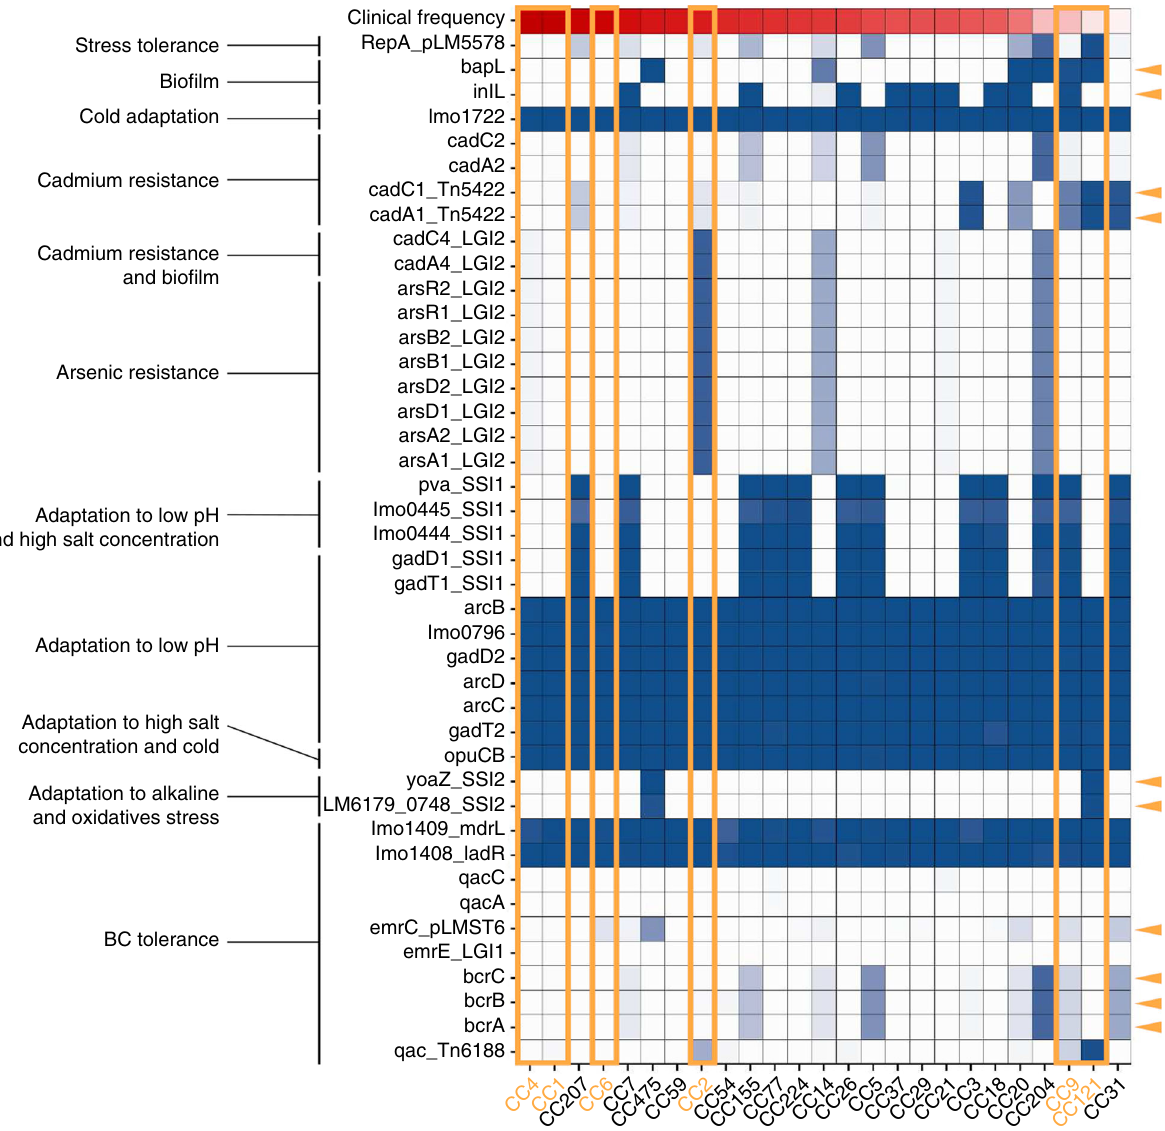
Fig. 5 Prevalence of stress resistance genes in Lm clones. We analyzed a set of 2928 genome sequences of non-redundant Lm isolates collected from 2015 to 2018 in the context of the French surveillance of listeriosis. Major CCs representing individually at least 0.5% of all the isolates of the study are shown. Prevalence of genes known to be involved in Lm stress resistance is shown per clone 21 . The blue intensity re fl ects the percentages of isolates harboring the considered genes. Clones are sorted according to their clinical frequency, represented with a red gradient at the top of the graph. Clones analyzed with in vivo and in vitro experiments in this study (i.e., CC1, CC2, CC4, CC6, CC9, and CC121) are highlighted with orange rectangles. Genes are sorted according to their function. Orange arrows indicate genes that are enriched in clones having a low clinical frequency. LGI: Listeria genomic island. SSI: Stress survival islet. BC: Benzalkonium